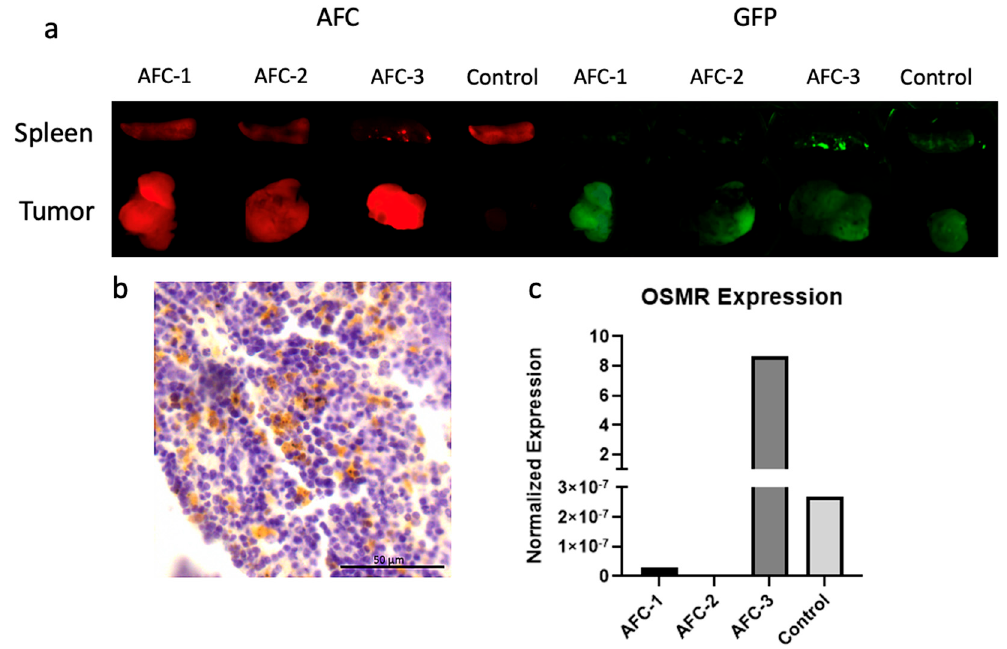
Figure 5. Pharmacokinetics of the AFC and the Correlation to OSMR Expression. ( a ) Fluorescent imaging of mouse spleens and tumors after treatment with AFC. Samples 1–3 received AFC treatment and sample 4 received saline control. AFC appears red (Left) and SS tissue appears green due to GFP (Right). ( b ) Immunohistochemistry of spleen metastasis for GFP from AFC-3 sample. GFP presence indicates sites of disease and appears brown. ( c ) RTqPCR data showing expression levels of OSMR. AFC and Control samples correlate to Figure 5a.